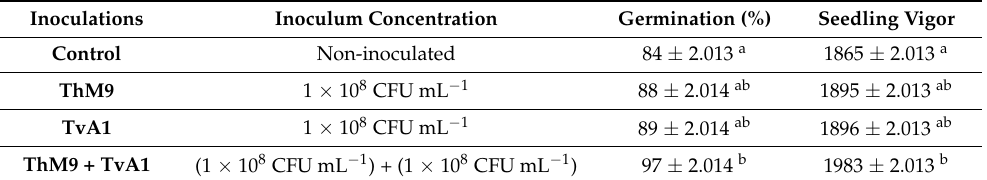
Table 2. Effect of ThM9 and TvA1 endophytes on seed germination and seedling vigor index of luffa. Seedling vigor index was calculated on percentage germination and mean root and shoot lengths of the seedlings. The values are mean from three experiments and designated with the different letters show significant differences according to Tukey’s HSD test at p = 0.05.